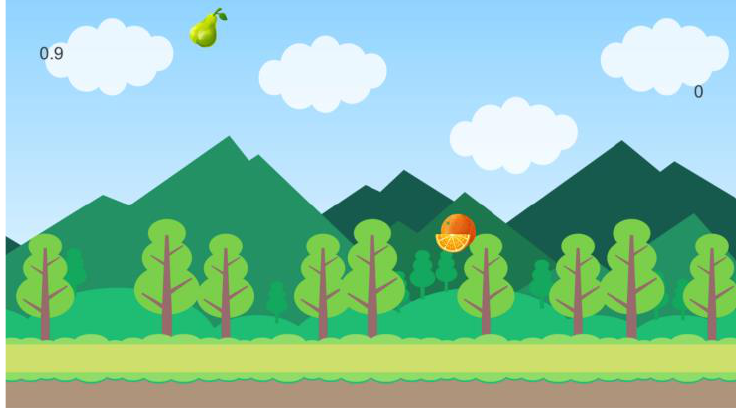
Figure 3. Screenshot illustrating playing the game “Catch the Fruits”.